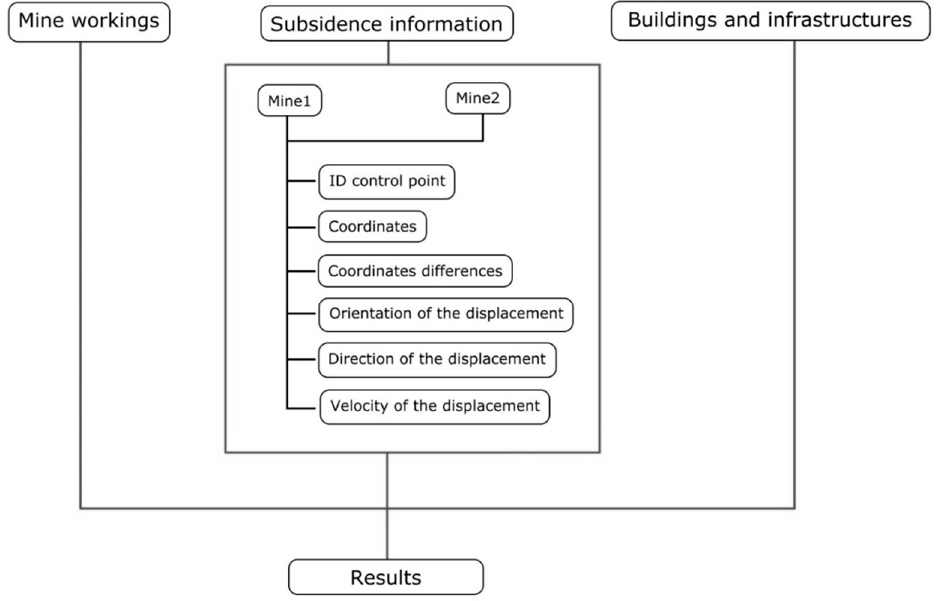
Figure 3. Model designed to manage subsidence.